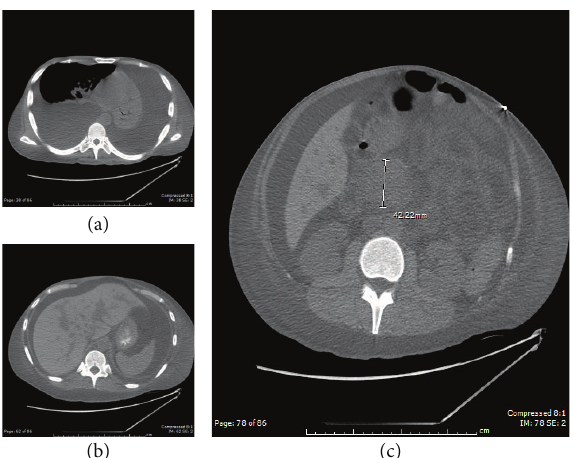
Figure 1: CT scans of the chest and abdomen show large bilateral pleural effusions (a) and severe ascites (b). There is a 4.2 cm mass in the head of the pancreas